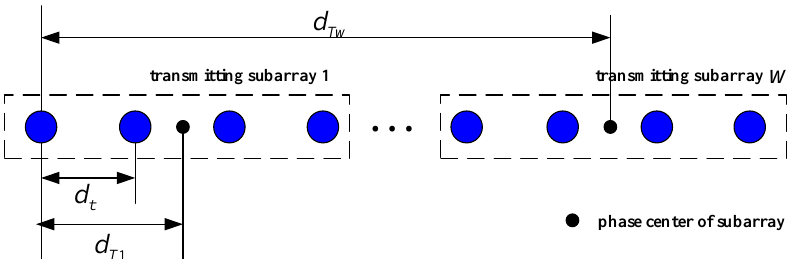
Figure 2. Spatial structure of the transmitting subarray. The phase center intervals of the transmitting subarray 1 and w are respectively denoted as d . Figure 2 shows that the phase center interval of the transmitting Tw